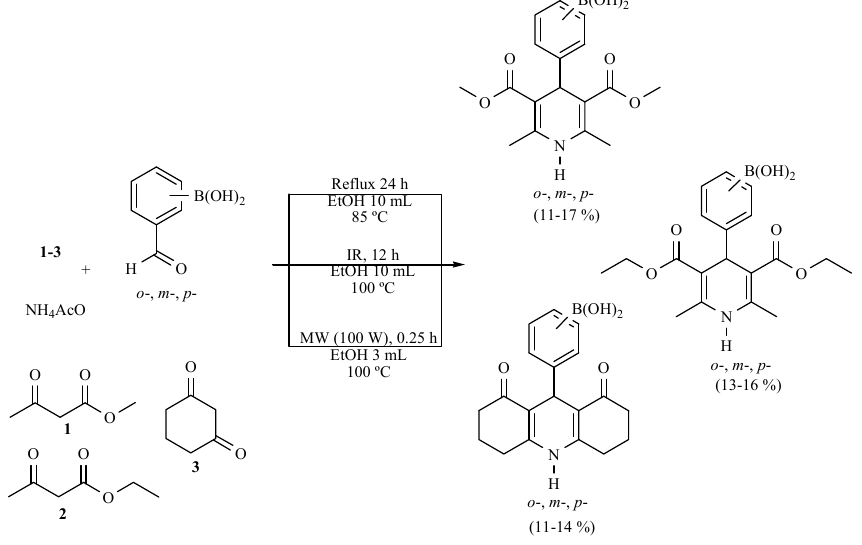
3,4-dihydropyrimidinones (Scheme 20) were obtained from the corresponding regioisomeric formylphenylboronic acids. The target molecules were obtained in a comparative study (MW vs . MH vs . NIR) using ethanol as a green solvent. The infrared irradiation process was not the best procedure, but it can be considered as an alternative for generating these molecules according to the green chemistry protocol